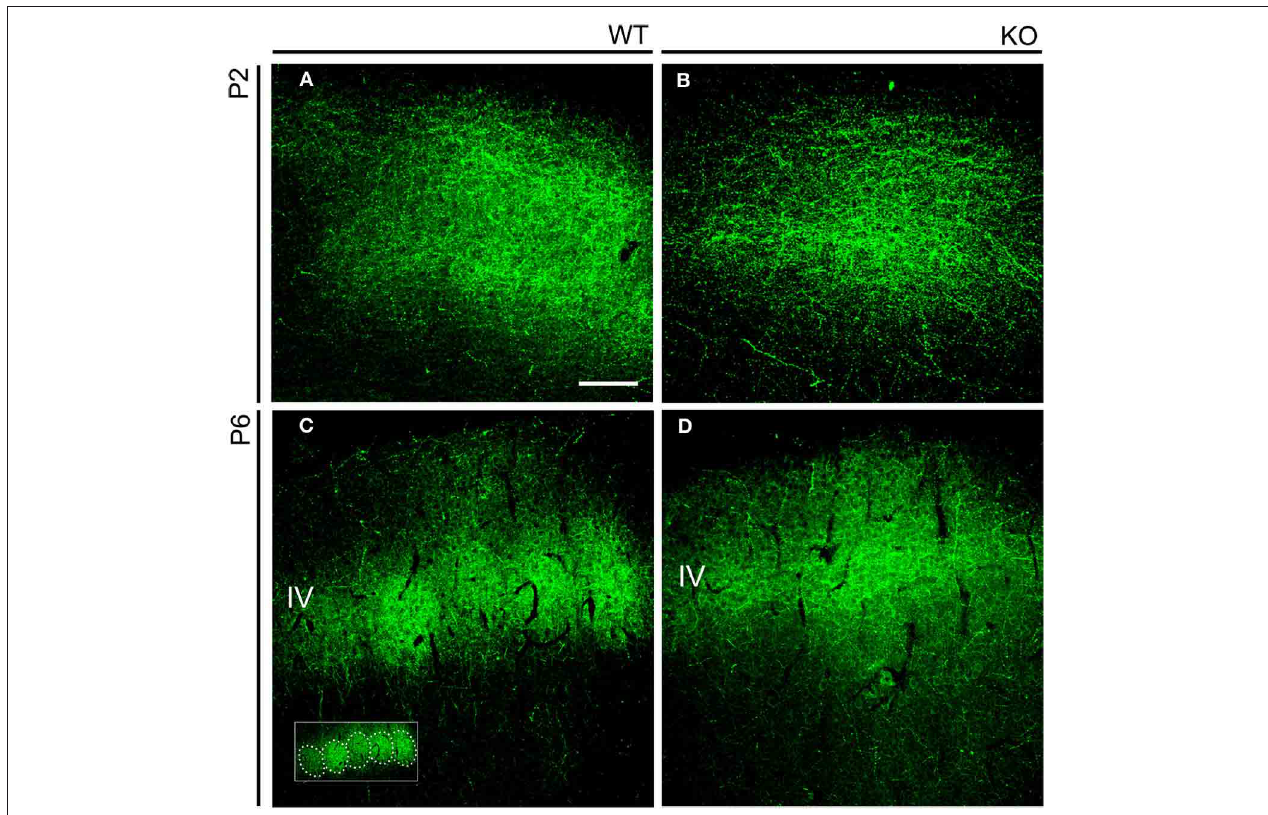
serotonin immunoreactivity clustered in layer IV in a manner reminiscent of barrels (highlighted in the inset) in wild type animals (C) . In P6 NCAM null mutant mice, TC axons also localized to layer IV but showed a continuous distribution (D) . Confocal optical sections. IV, cortical layer IV. Bar: 100 μ